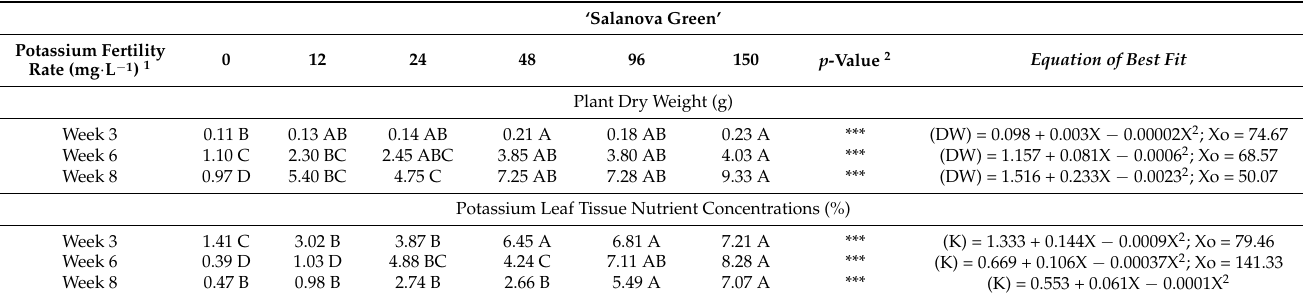
Table 4. Impact of potassium fertility rate on plant dry weight and potassium leaf tissue concentration on ‘Salanova Green’ lettuce.